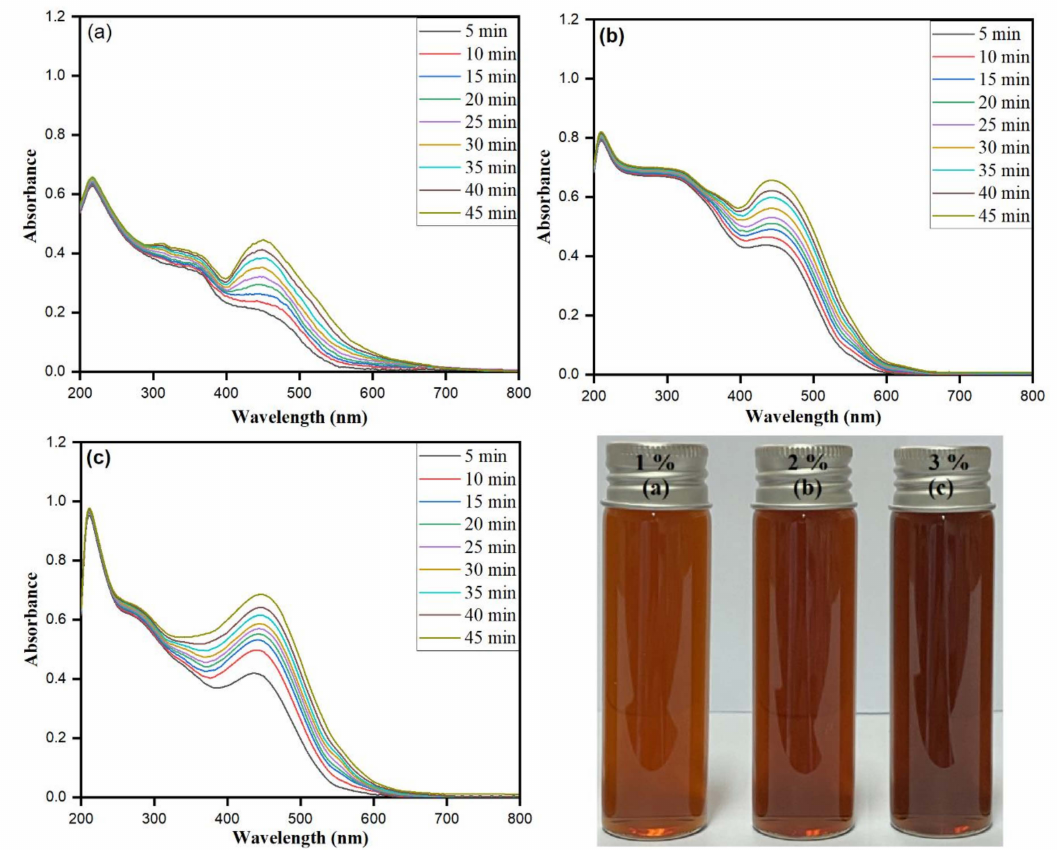
Figure 3. UV–visible absorption spectra of AgNPs recorded as a function of Matricaria chamomilla L. extract inoculum dose from 1% to 4%: ( a ) 1%, ( b ) 2.0%, and ( c ) 3%, at constant AgNO 3 concentration (2 mM) and exposure for 5 to 45 min to bright sunlight. (Optical images of AgNPs at di ff erent Matricaria chamomilla L. extract concentrations: ( a ) 1%, ( b ) 2.0%, and ( c ) 3%, and constant AgNO 3 concentration (2